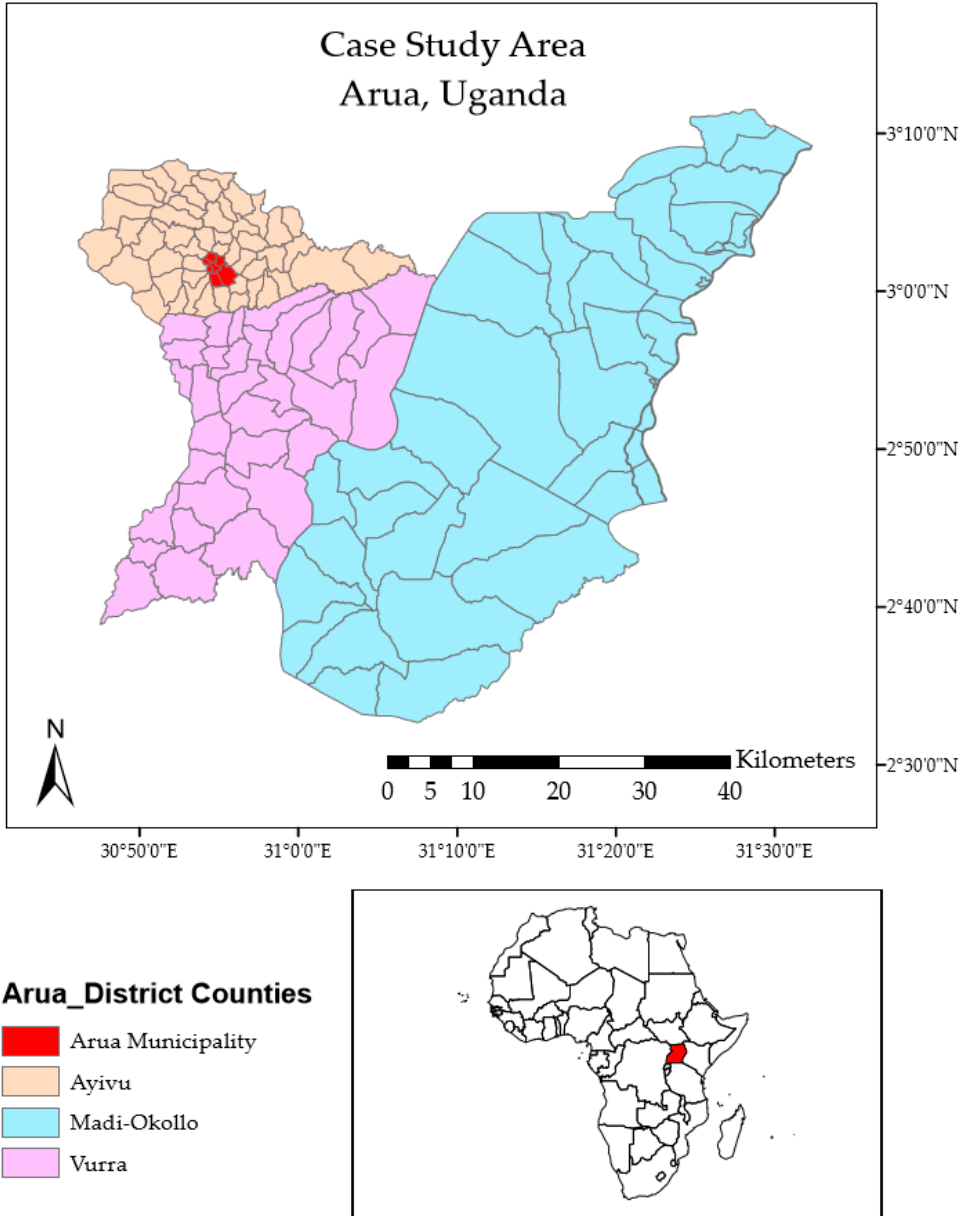
Figure 5. Geographic location of Arua, Uganda.